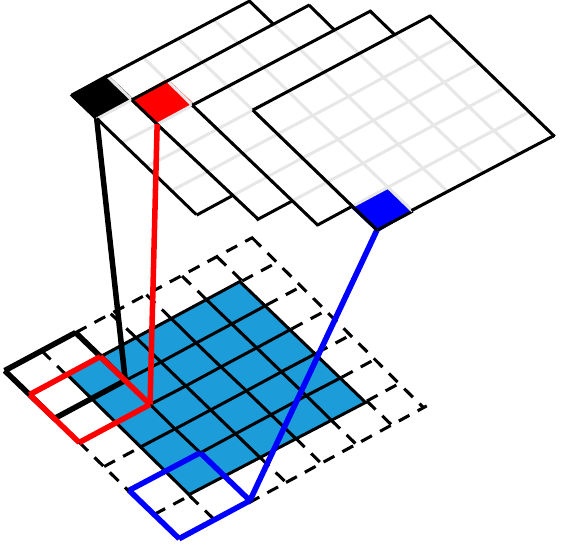
Figure 7. An example of a convolutional layer.